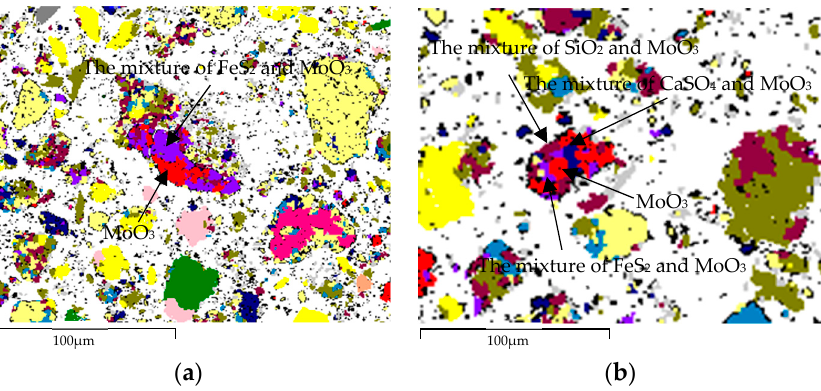
Figure 11. Enhanced backscattered electron microscope images of mixtures and MoO 3 in ammonia leaching residue. ( a ) position 1; ( b ) position 2.